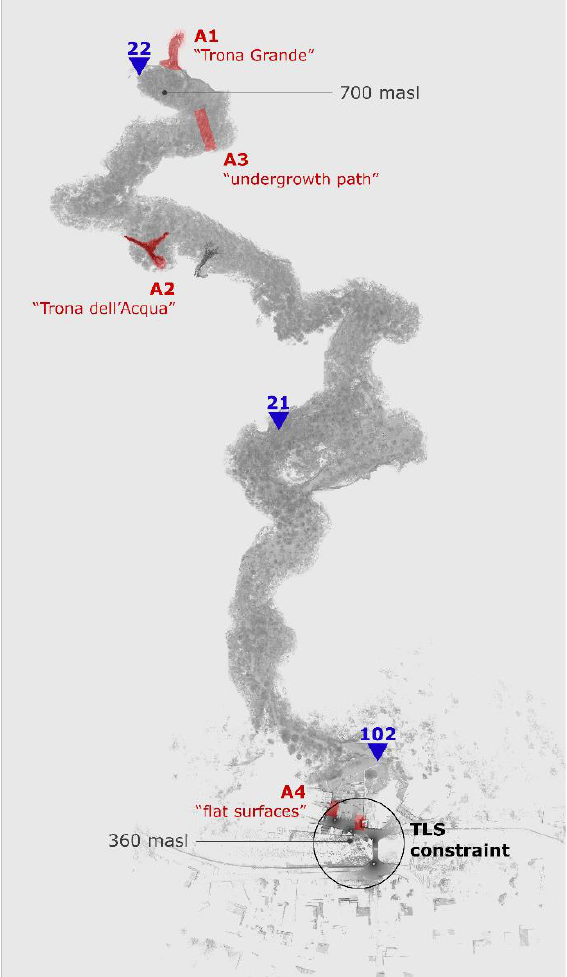
Figure 1. Footprint of the surveyed path. Check points are highlighted in blue. Areas for which the quality check is performed are red highlighted. The black circle shows the scans acquired with Terrestrial